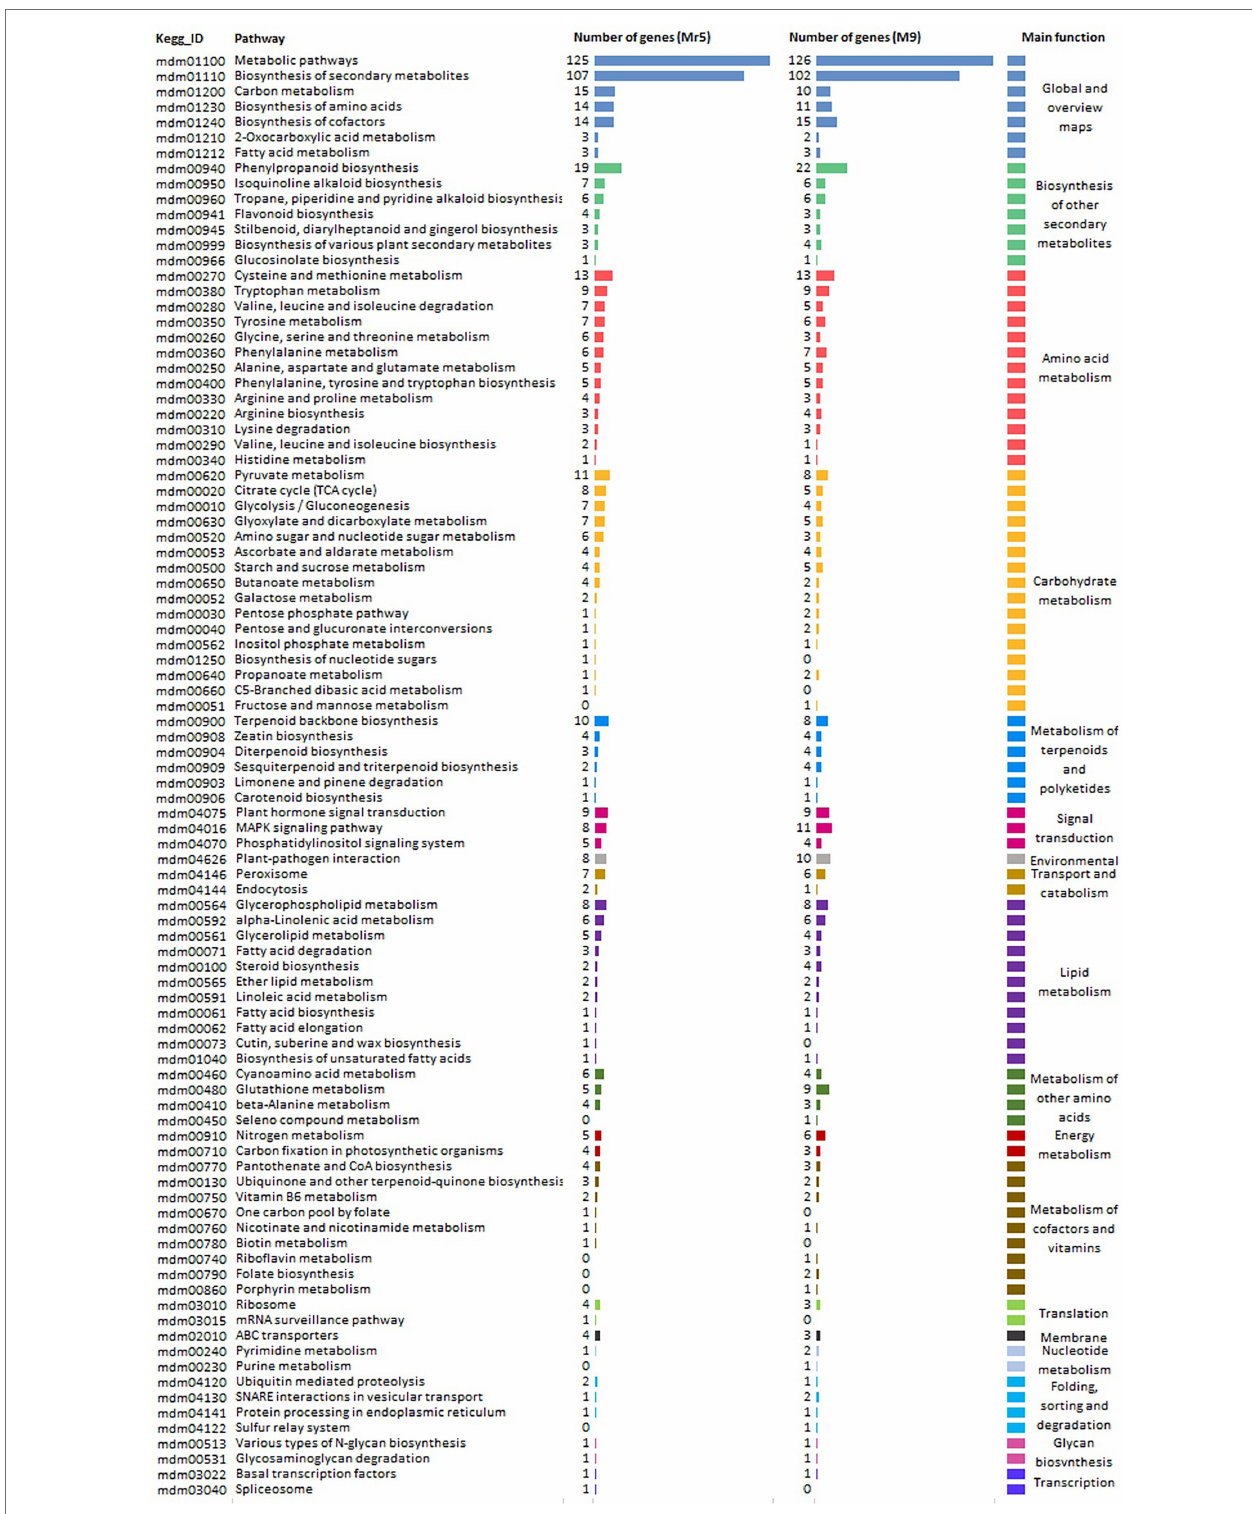
FIGURE 3 | Kyoto Encyclopedia of Genes and Genomes (KEGG) pathway enrichment analysis for 1,206 DEGs identified based on a log 2 FC > 1 with a significance level of p < 0.05. The DEGSs were identified for the ARD tolerant wild apple cultivar Mr5 and the susceptible rootstock ‘M9’ in root material after cultivation in ARD soil and γ ARD soil. 600 DEGs of Mr5 and 575 DEGs of ‘M9’ were assigned to significantly enriched pathways of 18 different major functions which are represented by a various